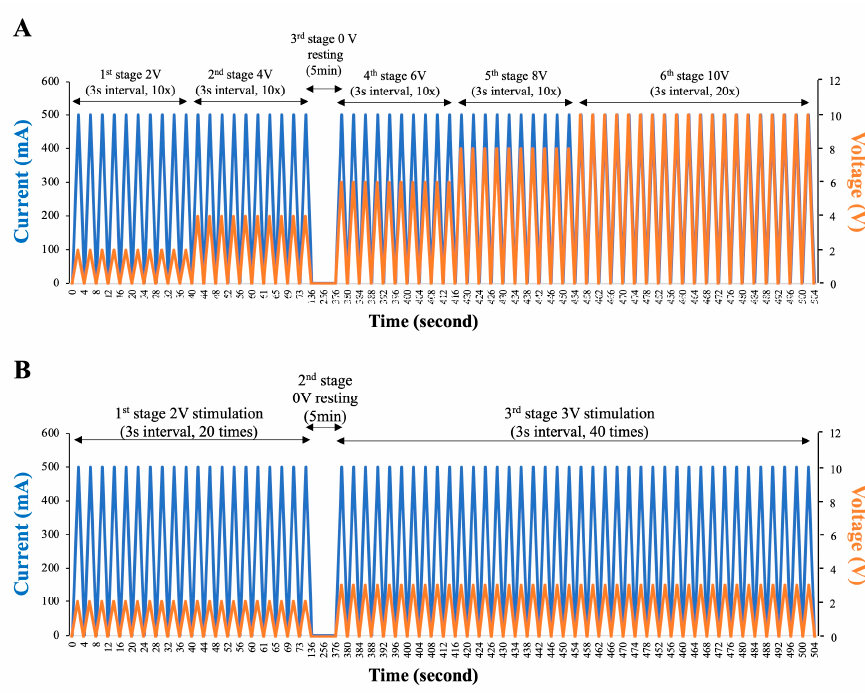
Figure 2. Electro-ejaculation protocols. ( A ) Traditional high voltage based stimulation protocol consisted of 6 different stages with stepwise increase of AC voltage from 2 to 10 volts (orange line) under a constant current of 500 mA (blue line). The probe was activated for 3 s for each stimulus from 2 volts for 10 stimuli, then changed to 4, 6, 8 volts for additional 10 stimuli, a final 20 stimuli with 10 volts was used. ( B ) Low-voltage based stimulation protocol established in this study consisted of 3 stages with a 2-step increase of AC voltage from 2 to 3 volts (orange line) under a constant current of 500 mA (blue line).